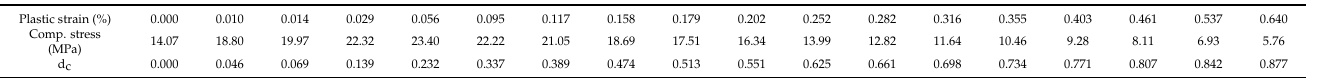
Table 6. Relationship of compressive stress, plastic strain, and damage factor of